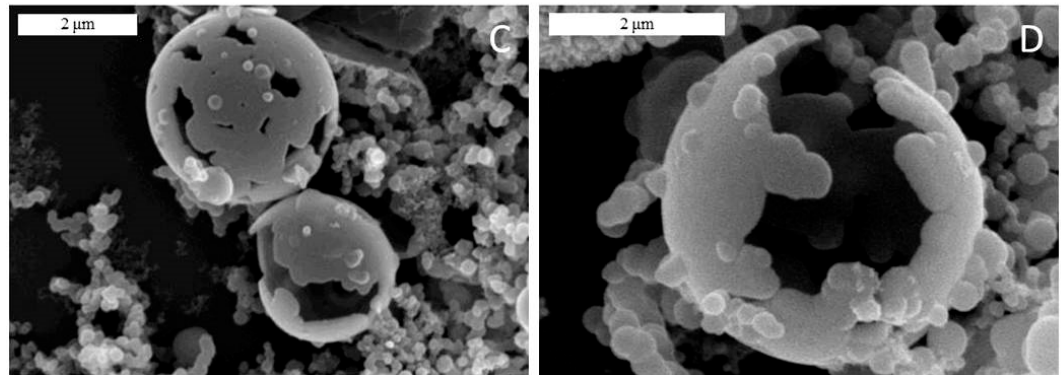
Figure 9. Particle degradation study. ( A , B ) Scanning electron micrographs of emulsion-based core-shell microcapsules after being exposed to a pH 6.8 nanopure water for 2 min, and ( C , D ) after exposure to a pH 4.0 HCl solution for 15 s. The rounded and particulate character of the remaining shells may be showing a memory effect of the PILP droplets that had initially coalesced to form the shells.